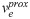
Examples of the firing response of 4 different cells for the various types of presynaptic activity (color-coded) shown in Fig 4.The abscissa “increasing synaptic quantity” corresponds to the comodulations of the model variables shown in Fig 4A (same color code). As an example, the response to a “proximal activity increase” (blue curve) corresponds to a linear increase of νeprox and νiprox while keeping νedist, νidist and s to their baseline level. See Fig 4A for the comodulations of the other types of increasing activity.